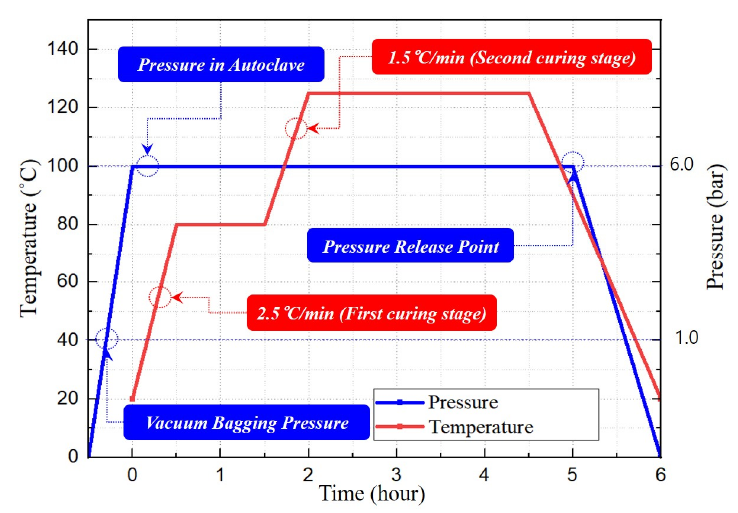
Figure 10. Auto-clave curing cycle for composite structure.